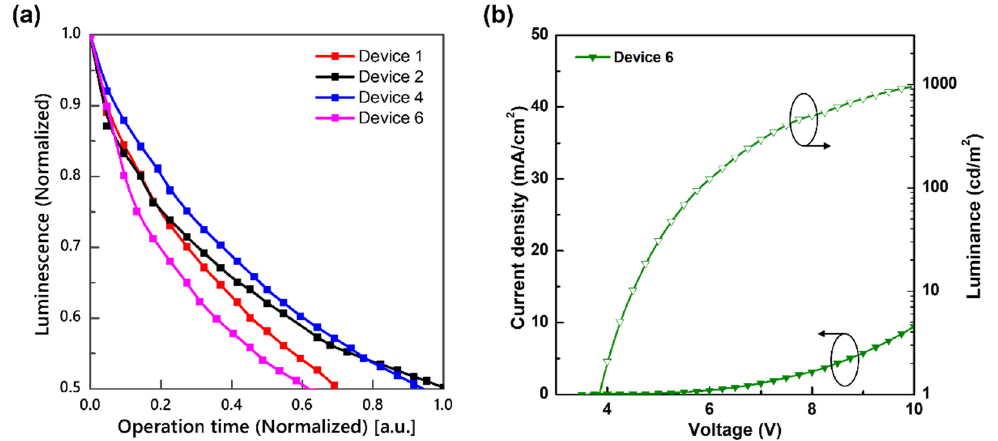
Figure 6. ( a ) Normalized luminescence of blue TADF OLEDs at J = 10 mA/cm 2 as a function of operating time of devices 1, 2, 4, and 6, and ( b ) J-V-L characteristics of device 6. Device 6: NPB 30 nm/TCTA 20 nm/mCP 10 nm/DPEPO: DMAC-DPS 10 wt% 30 nm/DPEPO 20 nm/TPBi 30 nm/LiF 2 nm/Al 80 nm.